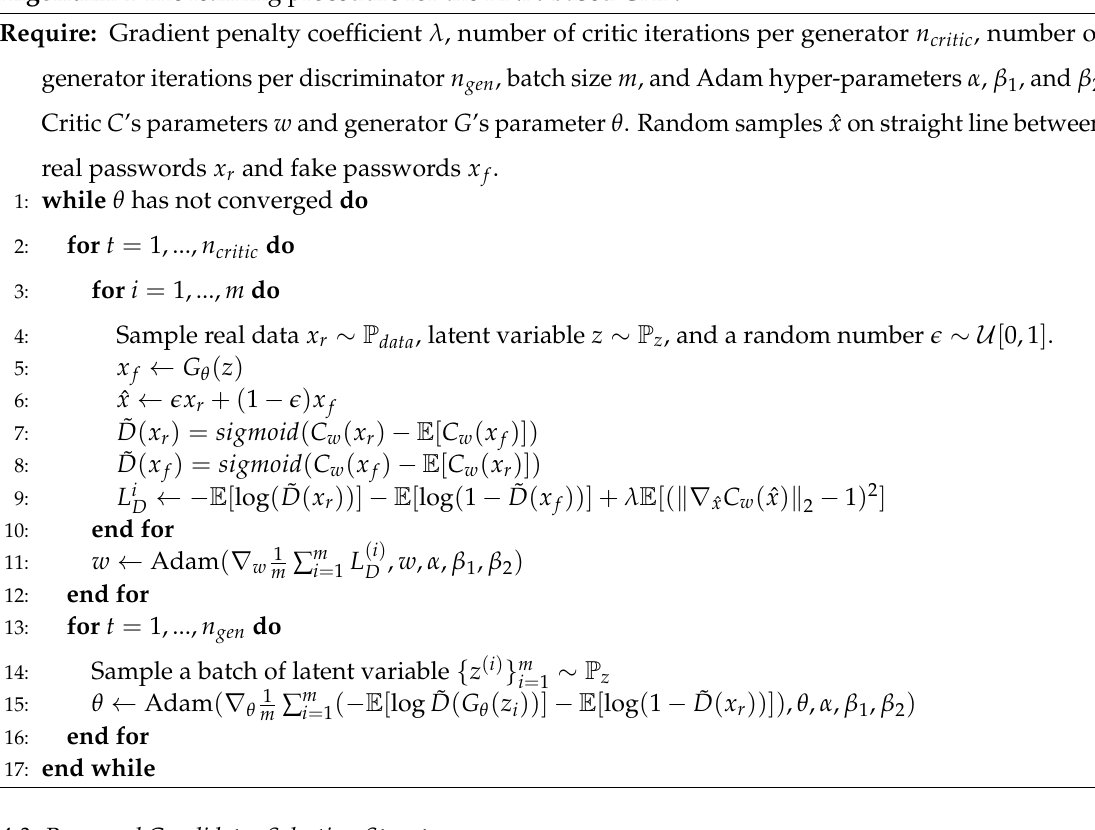
Algorithm 1 The learning procedure for the RNN-based